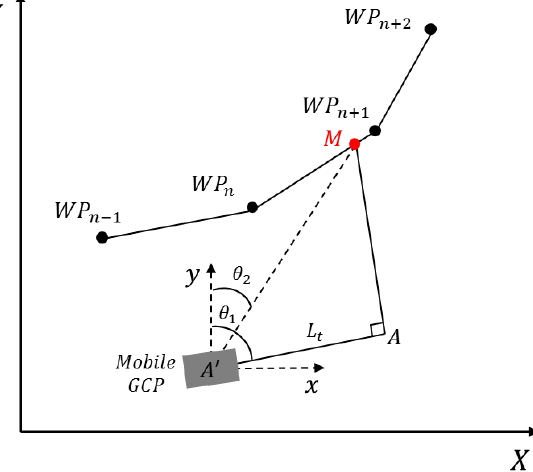
Figure 3. Schematic diagram of the look-ahead tracking method for locating subsequent target points on the path and determining corresponding steering angles (nomenclature: WP = waypoint; M = target point; A = imaginary point; A (cid:48) = current location; L t = look-ahead distance; θ 1 = new waypoint angle; θ = heading 2